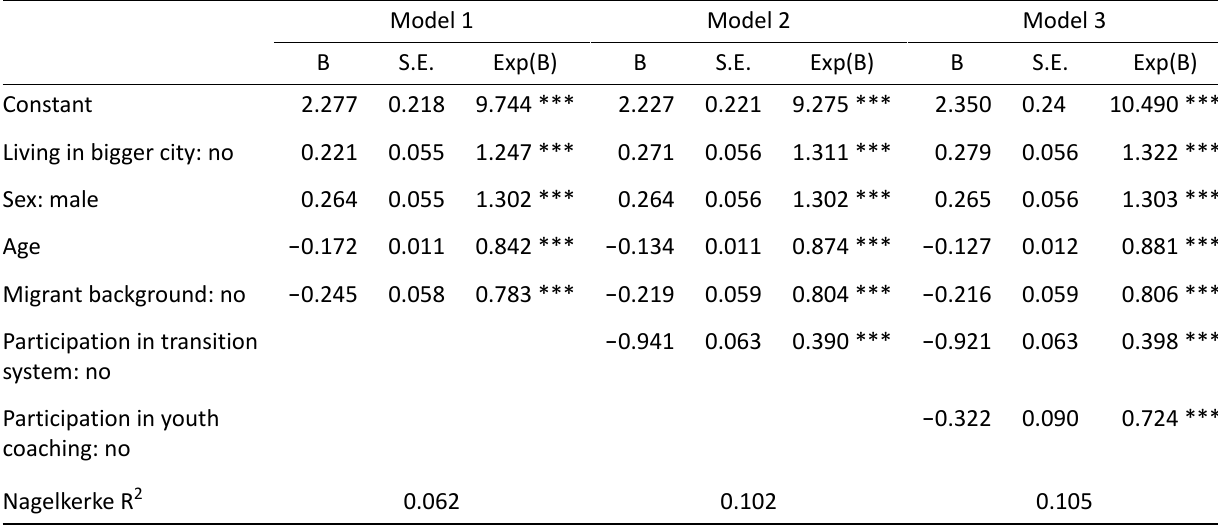
Table 5. Logistic regression models explaining integration in education or employment 24 months later (n =